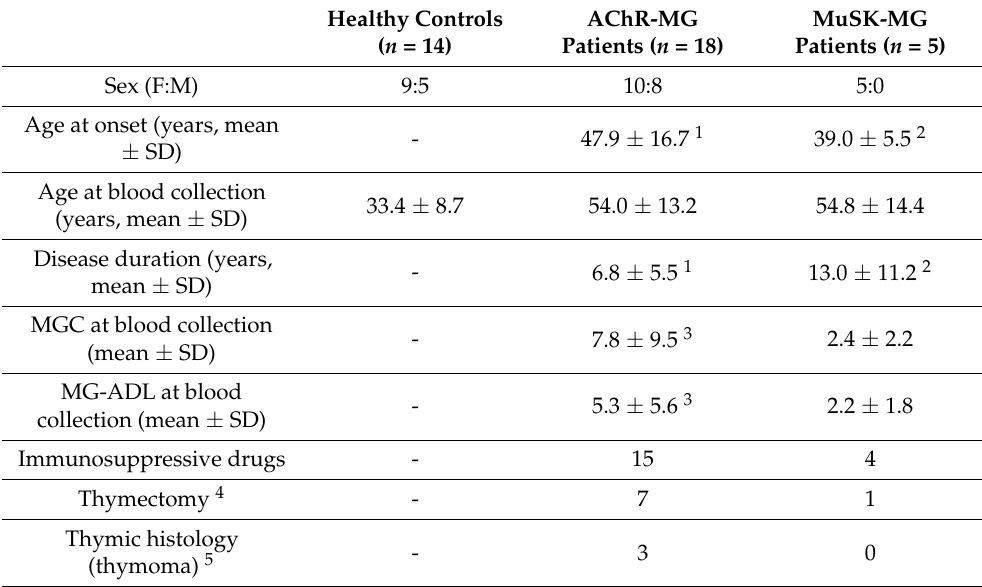
Table 1. Summary of the Main Features of AChR-MG and MuSK-MG Patients, and Healthy Controls Included in the